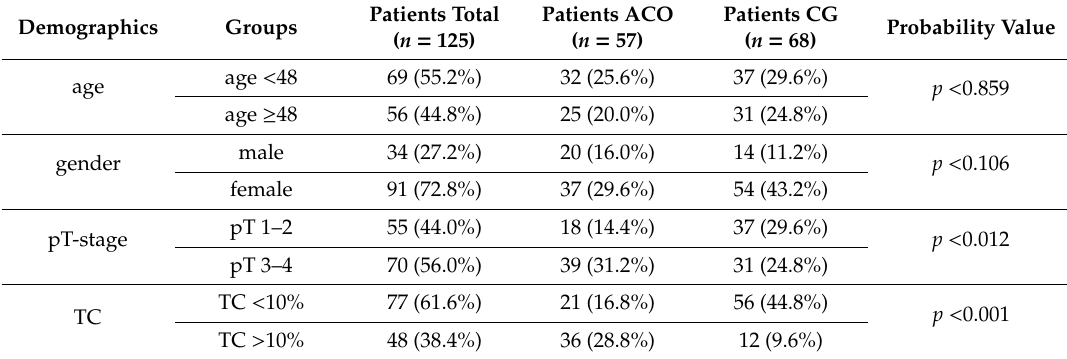
Table 6. Clinicopathologic characteristics of the study collective with relapse after initial RAI (“adverse outcome”, ACO) and the control group (CG), TC (tall cell), chi-square test.